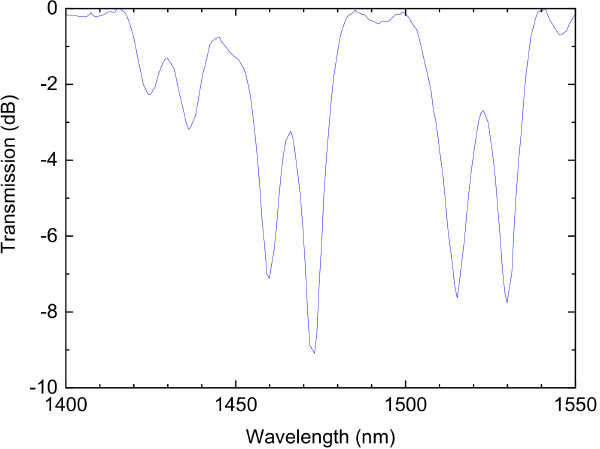
Figure 16. Gratings spectra containing a dual set of resonances inscribed simultaneously in the B/Ge codoped fiber. Reprinted with permission from ref. [130]. © 2007 The Optical Society.